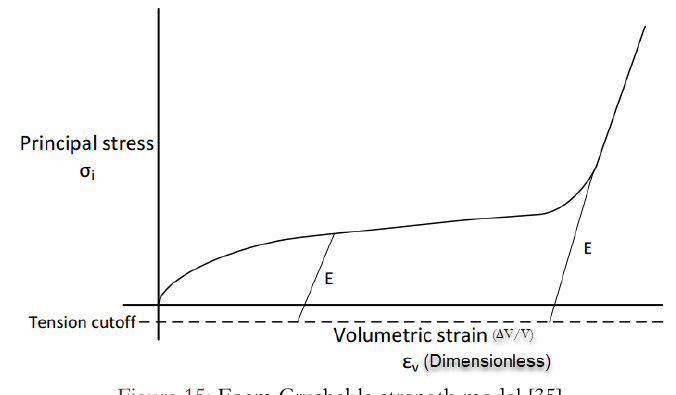
Figure 15: Foam Crushable strength model [35].